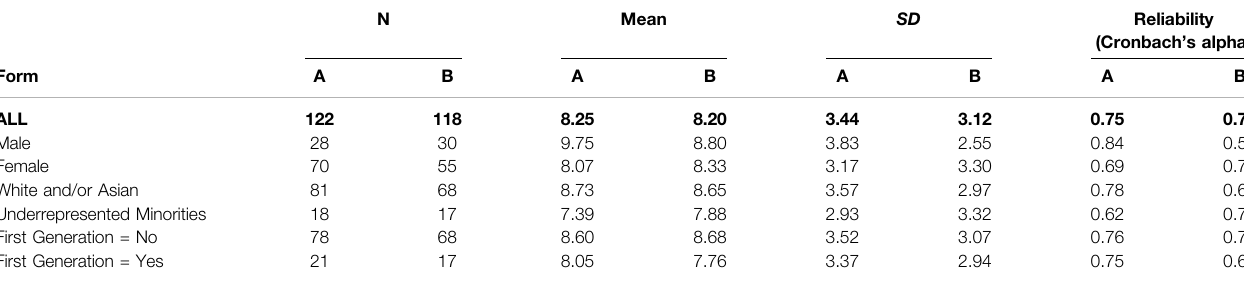
TABLE 4 | Descriptive statistics for forms a and B, by subgroups.